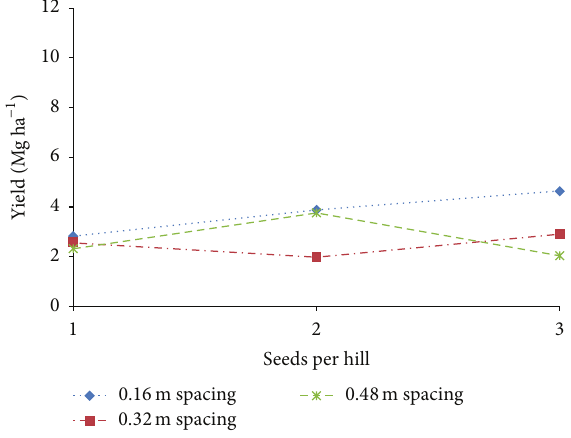
Figure 2: Grain yield (Mgha −1 ) averaged across replications as influenced by plant spacing (0.16m, 0.32 m, and 0.48 m) and the number of seeds per hill (1, 2, and 3) at Lake Carl Blackwell (LCB) location, 2012.